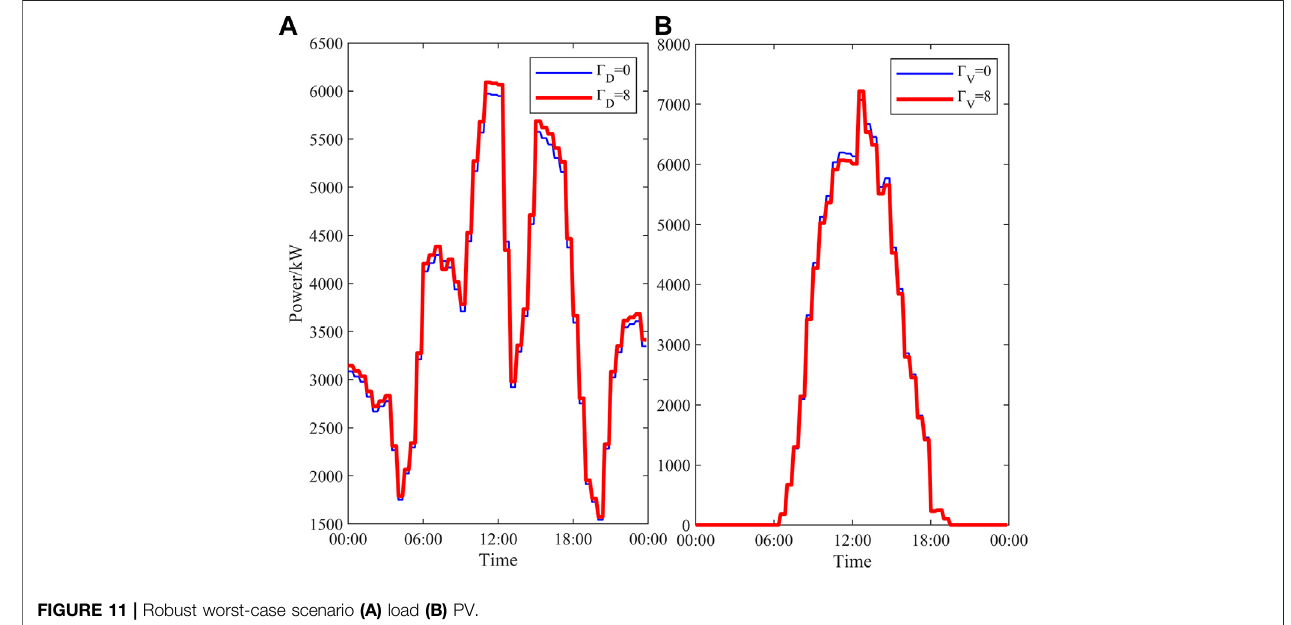
FIGURE 11 | Robust worst-case scenario (A) load (B) PV.